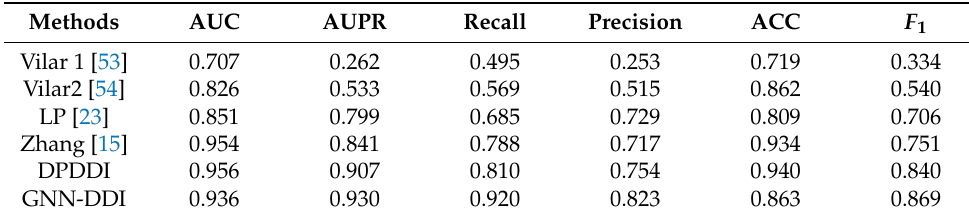
Table 1. Results of GNN-DDI and other five methods in the first prediction scenario. Methods